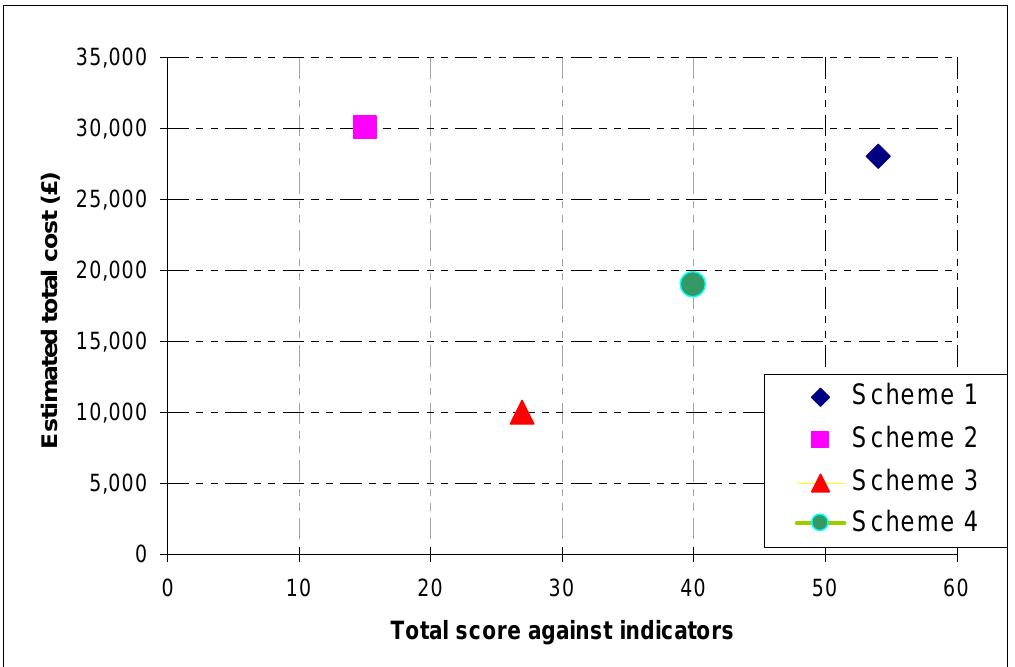
Figure 2. Comparison of score against